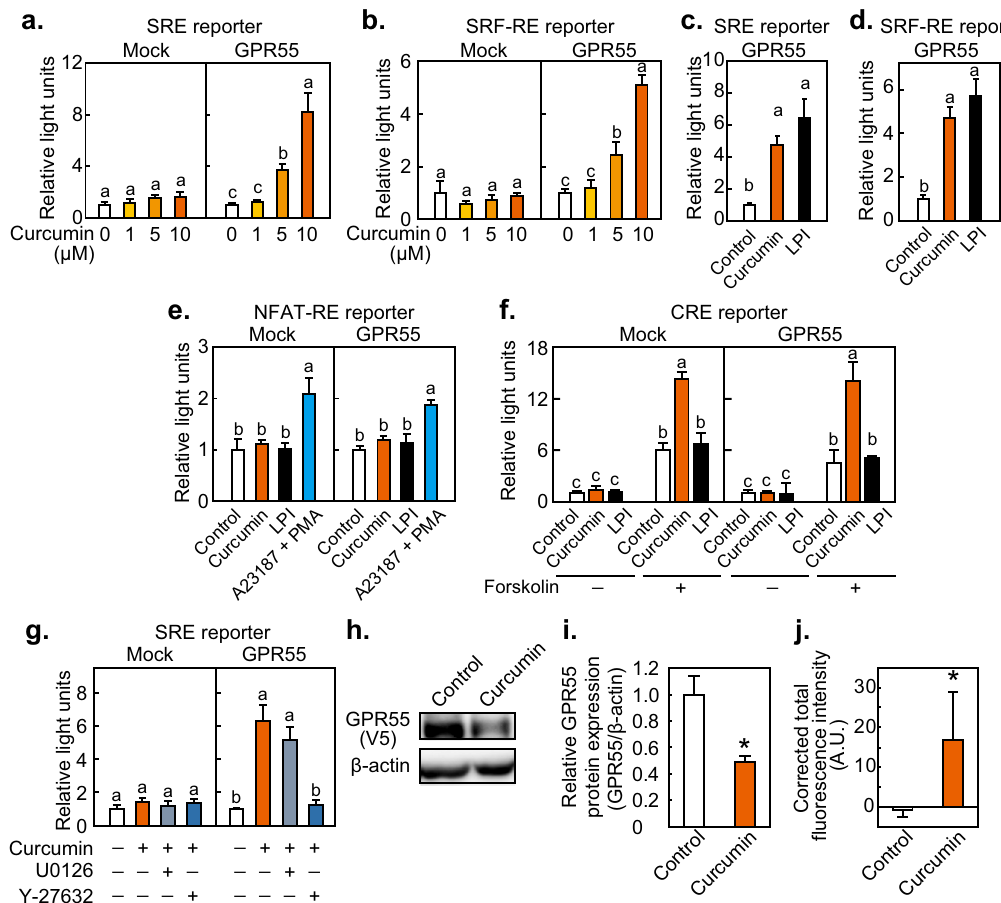
Fig. 1 Activation of GPR55 by curcumin. HEK293-FT cells transfected with a GPR55 expression vector and fi re fl y and Renilla luciferase reporter vectors were stimulated with curcumin or lysophosphatidylinositol (LPI), and reporter assay was performed. The effects of curcumin and LPI were determined on ( a , c ) serum reponse element (SRE)-mediated transcription, ( b , d ) serum-response factor-response element (SRF- RE)-mediated transcription, ( e ) nuclear factor of activated T-cells-response element (NFAT-RE)-mediated transcription, and ( f ) cAMP-response element (CRE)-mediated transcription. g Effects of curcumin and signal transduction pathway inhibitors on SRE-mediated transctiption. Cells were stimulated by the indicated concentrations or 10 µM curcumin, 300 nM LPI, 5 µM A23187 + 10 ng/ml phorbol myristate acetate (PMA), 10 µM forskolin, 10 µM U0126, and/or 10 µM Y-27632. ( h , i ) GPR55 protein levels after stimulation with 10 μ M curcumin for 3 h. The band intensity of GPR55 was expressed relative to the band intensity of β -actin. j The GPR55-dependent change in Fura-8 fl uorescence was determined by subtracting the fl uorescence value in the vector-transfected cells from the fl uorescence value in the GPR55-expressing cells. Data were expressed as the mean ± s.d. ( n = 4) for luciferase and calcium assays or ( n = 3) for western blotting. Statistical analysis was performed on each of the wells transfected with the mock vector or the GPR55 expression vector. Different letters or an asterisk indicate signi fi cant differences ( p <